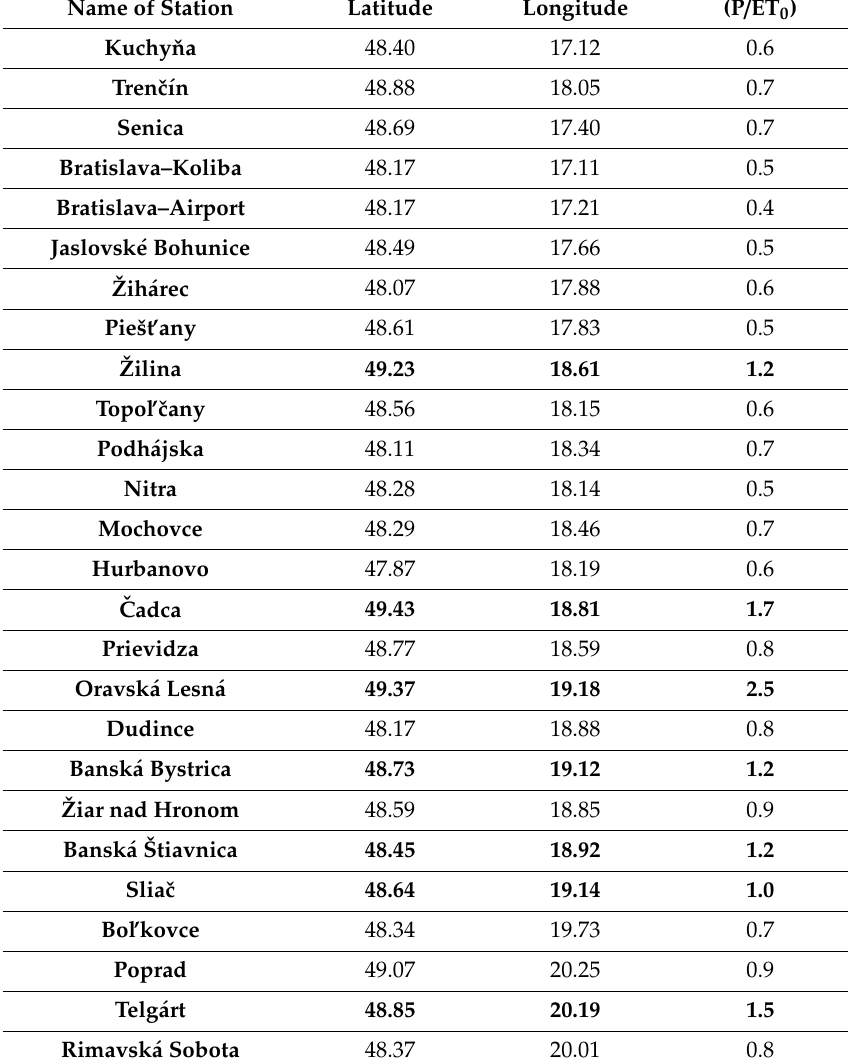
Table 2. Proportion of average annual precipitation in average reference evapotranspiration in